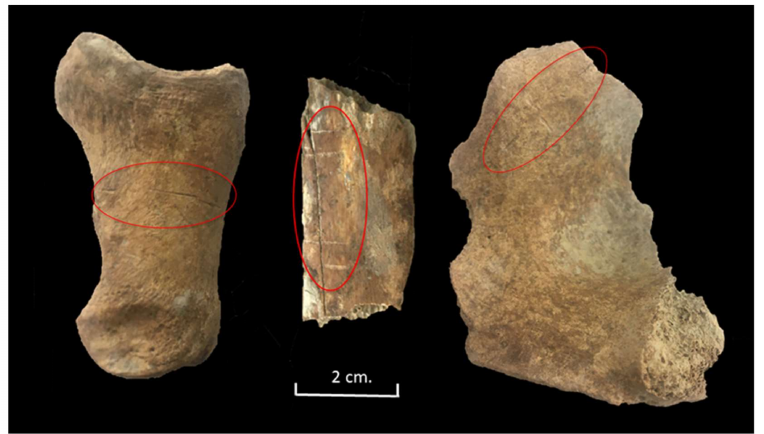
Figure 10. Cut marks documented on a bovine phalange, rib, and atlas from Stratigraphic Unit 1700 of the Vilauba pit.